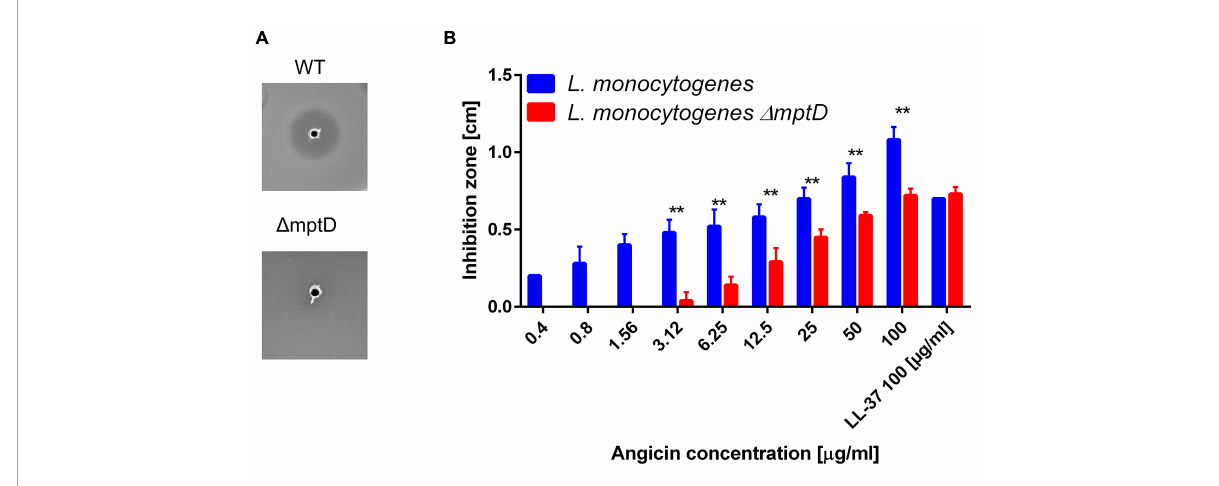
FIGURE4 Receptor specificity of Angicin activity. L. monocytogenes EGDe and its isogenic mutant EGDe (cid:49) mptD were used as target strains in a radial diffusion assay. Inhibition zones were quantified in cm, the AMP LL-37 served as positive control. Depicted is the mean + standard deviation of 5 independent experiments. (A) Mann-Whitney- U -test was performed to determine significant differences between the inhibition zone size of the wildtype or the mutant strain. A p -value < 0.01 is illustrated by **. (B) Picture of a one-layer RDA conducted with L. monocytogenes EGDe or its isogenic mutant EGDe (cid:49) mptD as target strains and S. anginosus BSU 1211 as bacteriocin